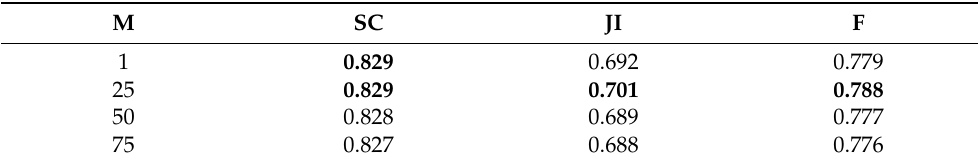
Figure 4. Effectiveness of window size to the segmentation results. ( a , b ) are images from [49,50]. The 1st to the 4th columns are the results for M = 1, M = 25, M = 50 and M = 75, respectively. Table 3. Quantitative comparisons using different window sizes for WSE database. The best results are highlighted in bold.